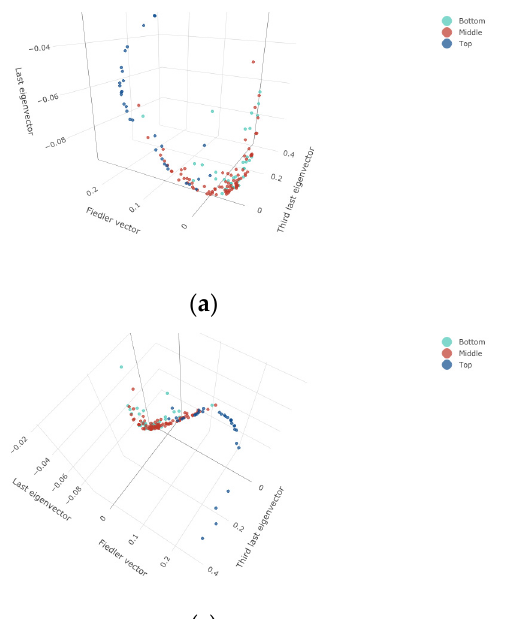
Figure 4. 2D scatter plot of Laplacian eigenmap using the Fielder vector and the third smallest ei- genvector. When the benchmarked classifications are mapped onto a network graph of the in- verse Euclidean distances (Figure 5), it can be seen that although top teams cluster to the bottom right, there is considerable overlap across all top, middle and bottom teams. In- deed, the average silhouette width values for the benchmark classifications were only 0.04, indicating that classification based on the national leagues’ points does not accurately reflect the natural groupings between the various European soccer clubs.